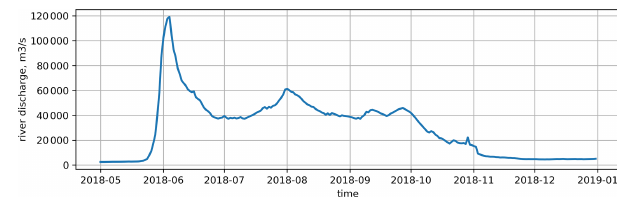
Figure 3. The Lena River discharge in 2018. Data taken from the Arctic GRO dataset (https://arcticgreatrivers.org/data/, last access: 24 January